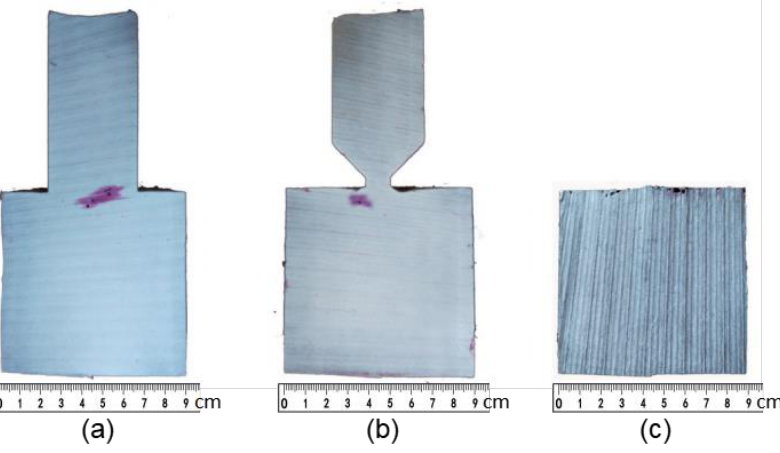
Figure 8. Cross-section topography of the prototypes poured at 1300 °C: ( a ) Prototype A2, macro porosity at the connection of the riser and casting; ( b ) Prototype B2, macro porosity and surface sink near the riser neck; ( c ) Prototype C2, surface sink at the upper surface of the casting.